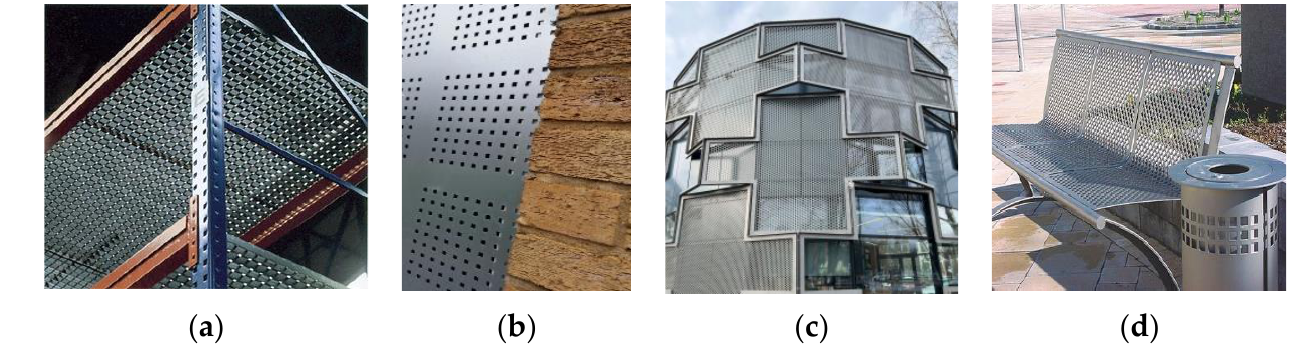
Figure 2. Structural units ( a , b ) and elements of building and garden furniture ( c , d ) from PMM. For the perforation of strips and sheets, the cold stamping method is usually used, which is implemented on stamping presses, as well as by using broad tape production lines [21]. Other methods for the production of PMMs are rapidly developing, for example, using liquid [22,23] and laser cutting [24]. The volumes of production and use of thin- sheet stamping products in the world are constantly growing and the biggest sector is the expanding automotive market (Figure 3) [25]. The most common PMMs are steel, aluminum and copper. The main feature of PMM is the presence of through holes of a given shape and size (Figure